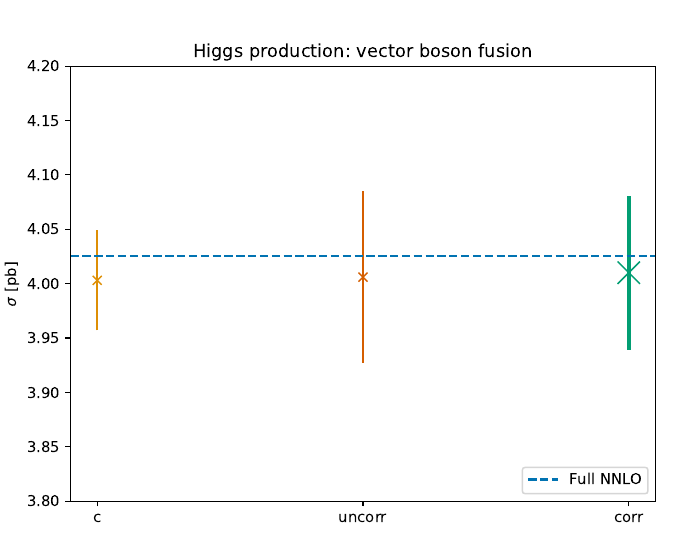
Table 4 . Same as table 3 for the NLO total cross sections for the Higgs production cross section √ by vector boson fusion at NLO for s = 13 TeV. In this case, the NNLO central value is 4 . 025 pb.